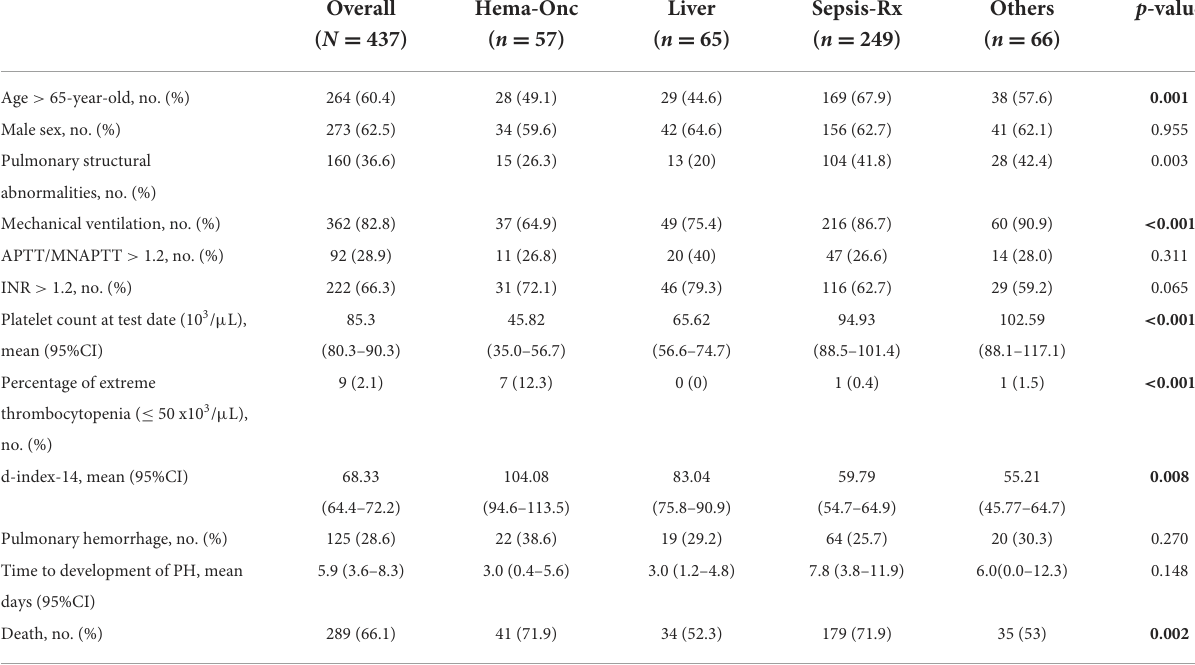
TABLE 3 Comparison of clinical characteristics and laboratory findings between patients with SM respiratory infections by different comorbidities.